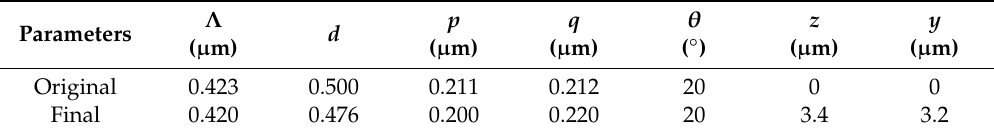
Table 1. Parameters of the grating part.